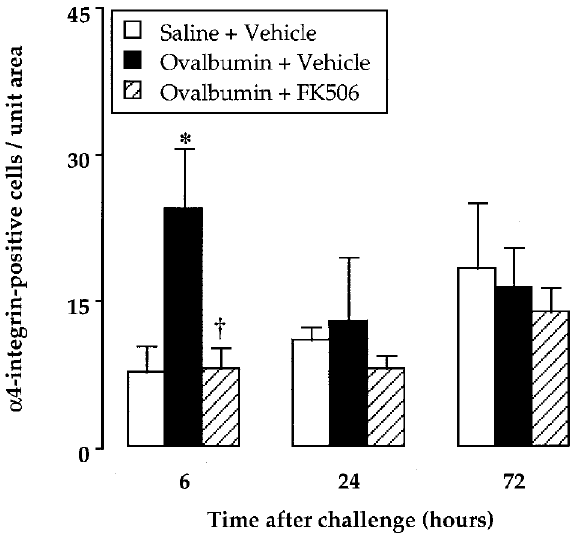
FIG. 6. Effect of FK506 on antigen-induced accumulation of a 4 integrin positive cells in pulmonary endothelium and perivascular compartment from sensitized guinea-pigs (HP1/ 2 staining and APAAP). Sensitized vehicle- or FK506 (0.5mg/ kg)-treated animals were challenged with intra-nasal saline or ovalbumin and lungs were used at 6, 24 or 72h. Results are means ± SEM of six experiments. * P < 0.05, compared with saline-challenged vehicle-treated guinea-pigs. † P < 0.05, compared